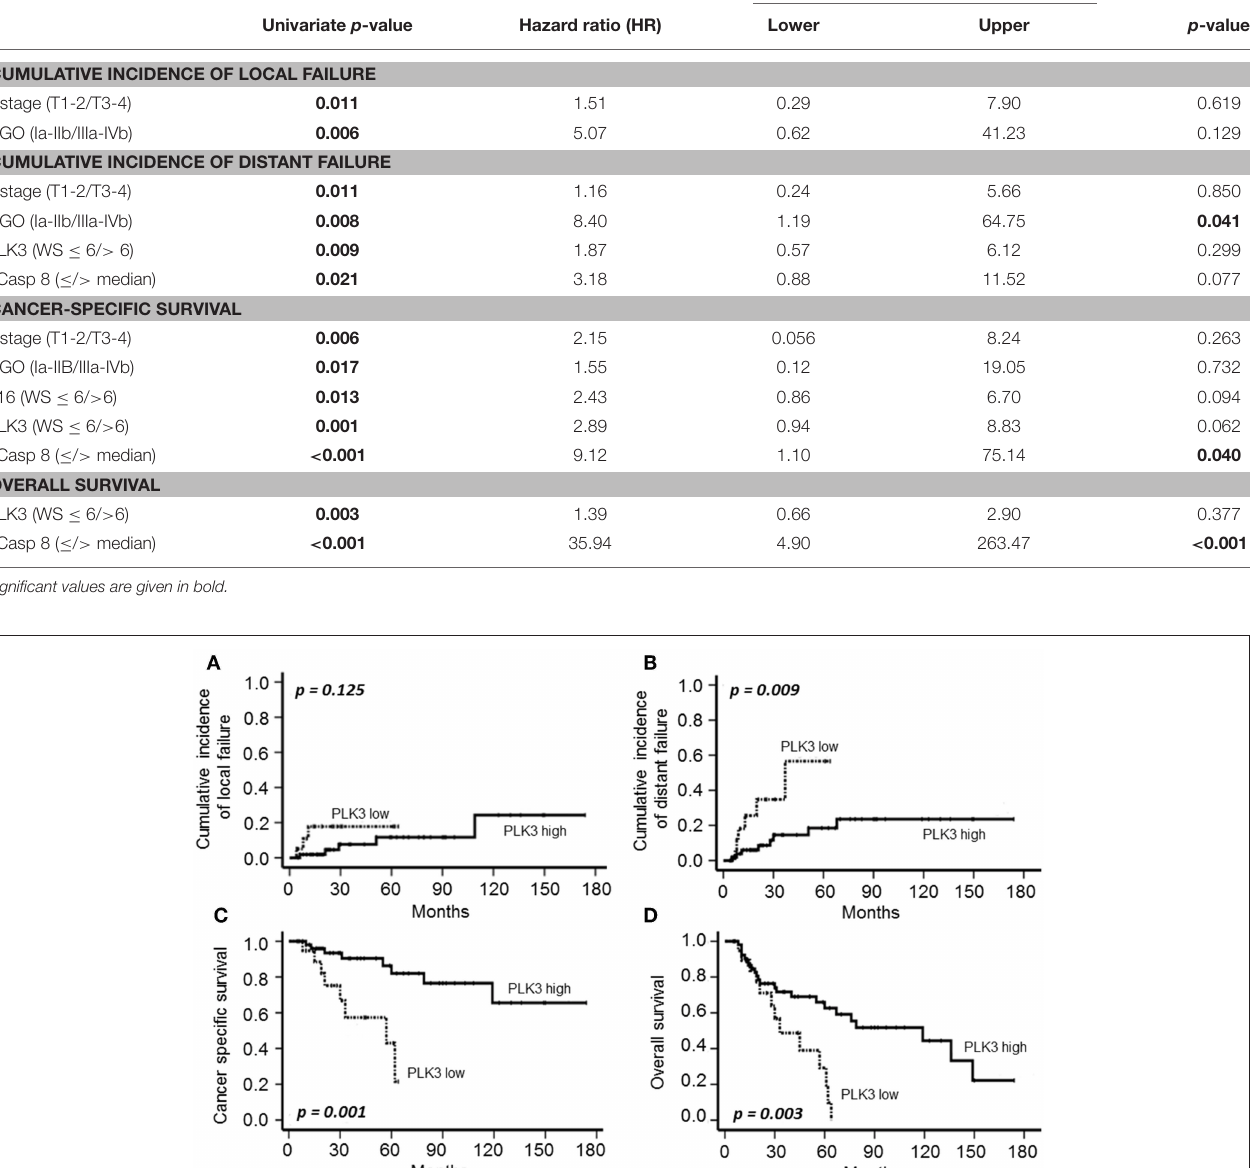
Multivariate analyses 95 % confidence interval (CI)